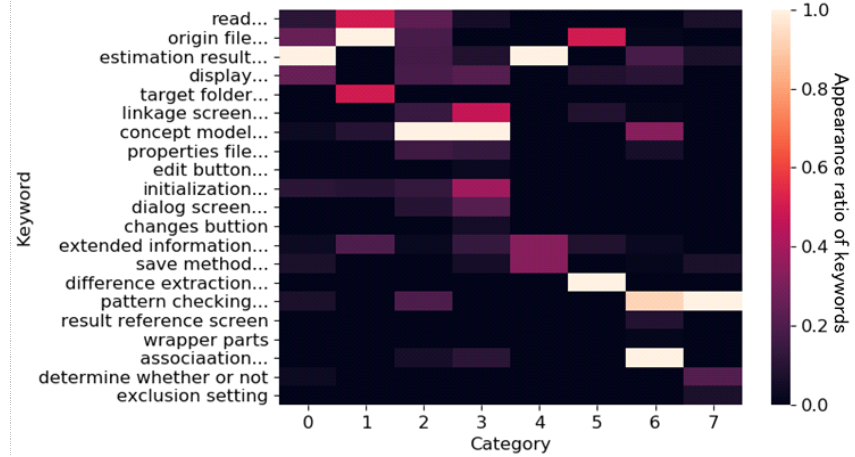
Figure 10. Appearance ratio of keywords in each ticket category (we translated keywords after applying our visualization method).